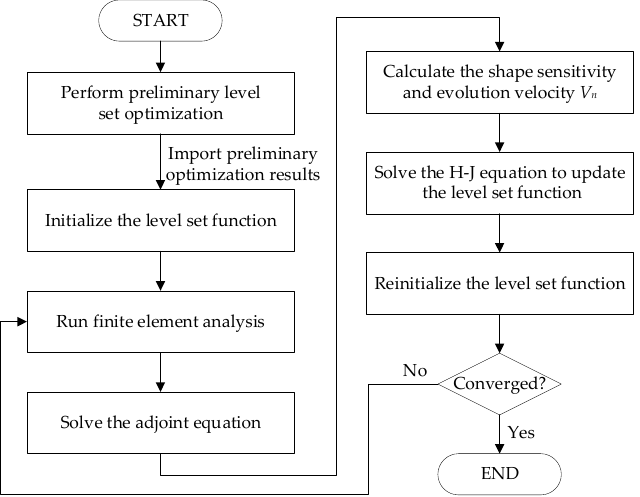
Figure 2. Flowchart of the level set topology optimization considering porosity constraints.